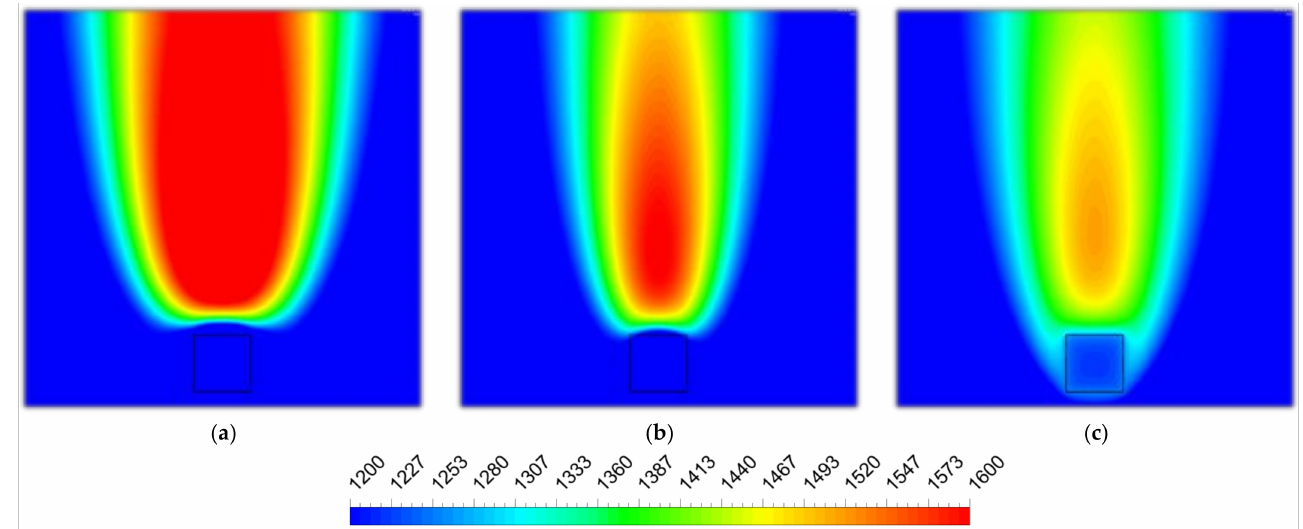
Figure 13. Distribution of temperature (in K) at ( a ) t = 25 s, ( b ) 40 s and ( c ) 75